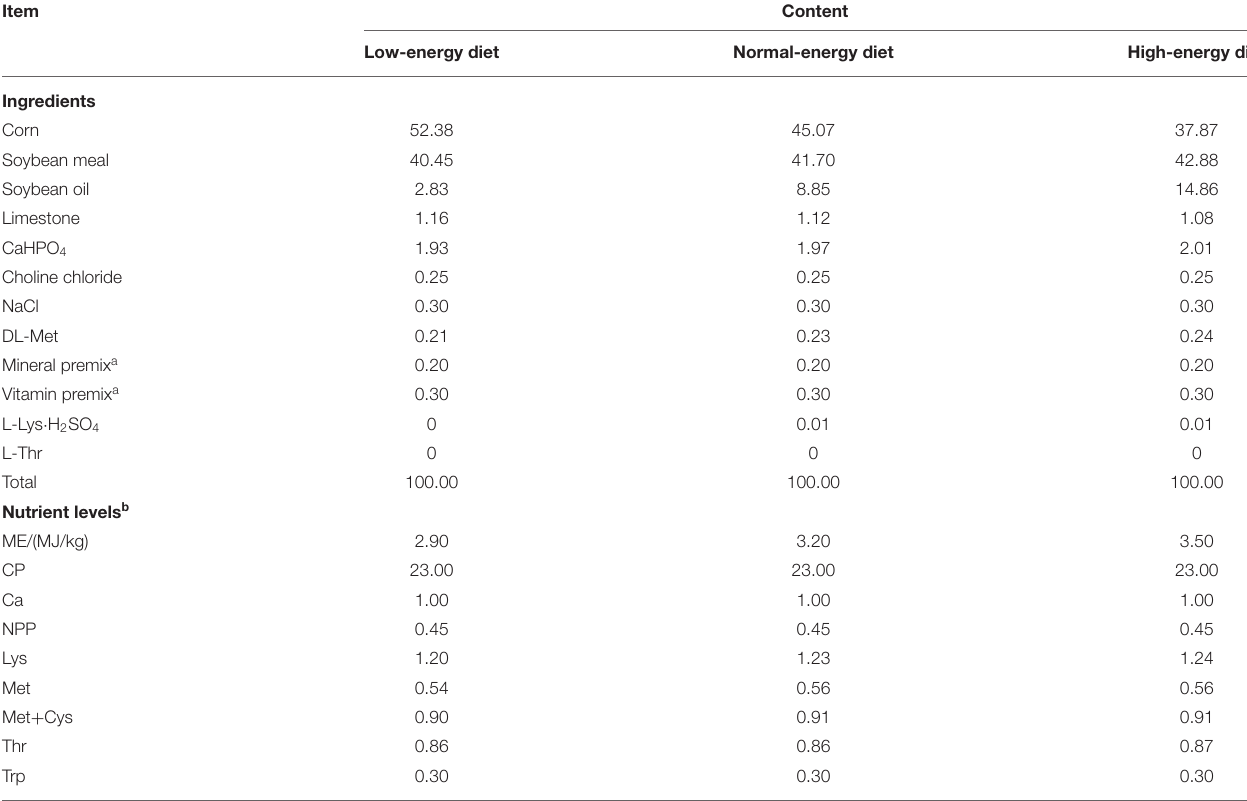
TABLE 1 | Composition and nutrient levels of experimental diets (dry basis).